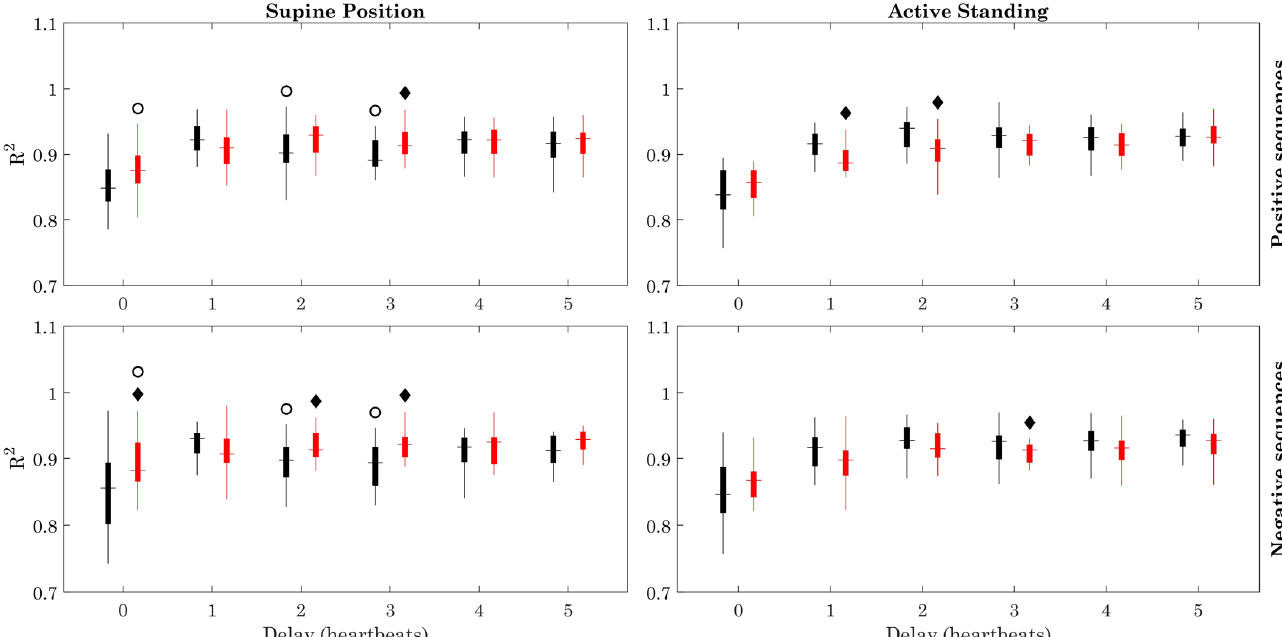
Figure 7. Determination coefficient (R 2 ). Figure symbology: Healthy subjects (black), ESRD patients (gray). Black diamond: ESRD vs. Healthy group (within same position), p < 0.05. Open circle: Supine Position vs. Active Standing (within same group), p < 0.05.